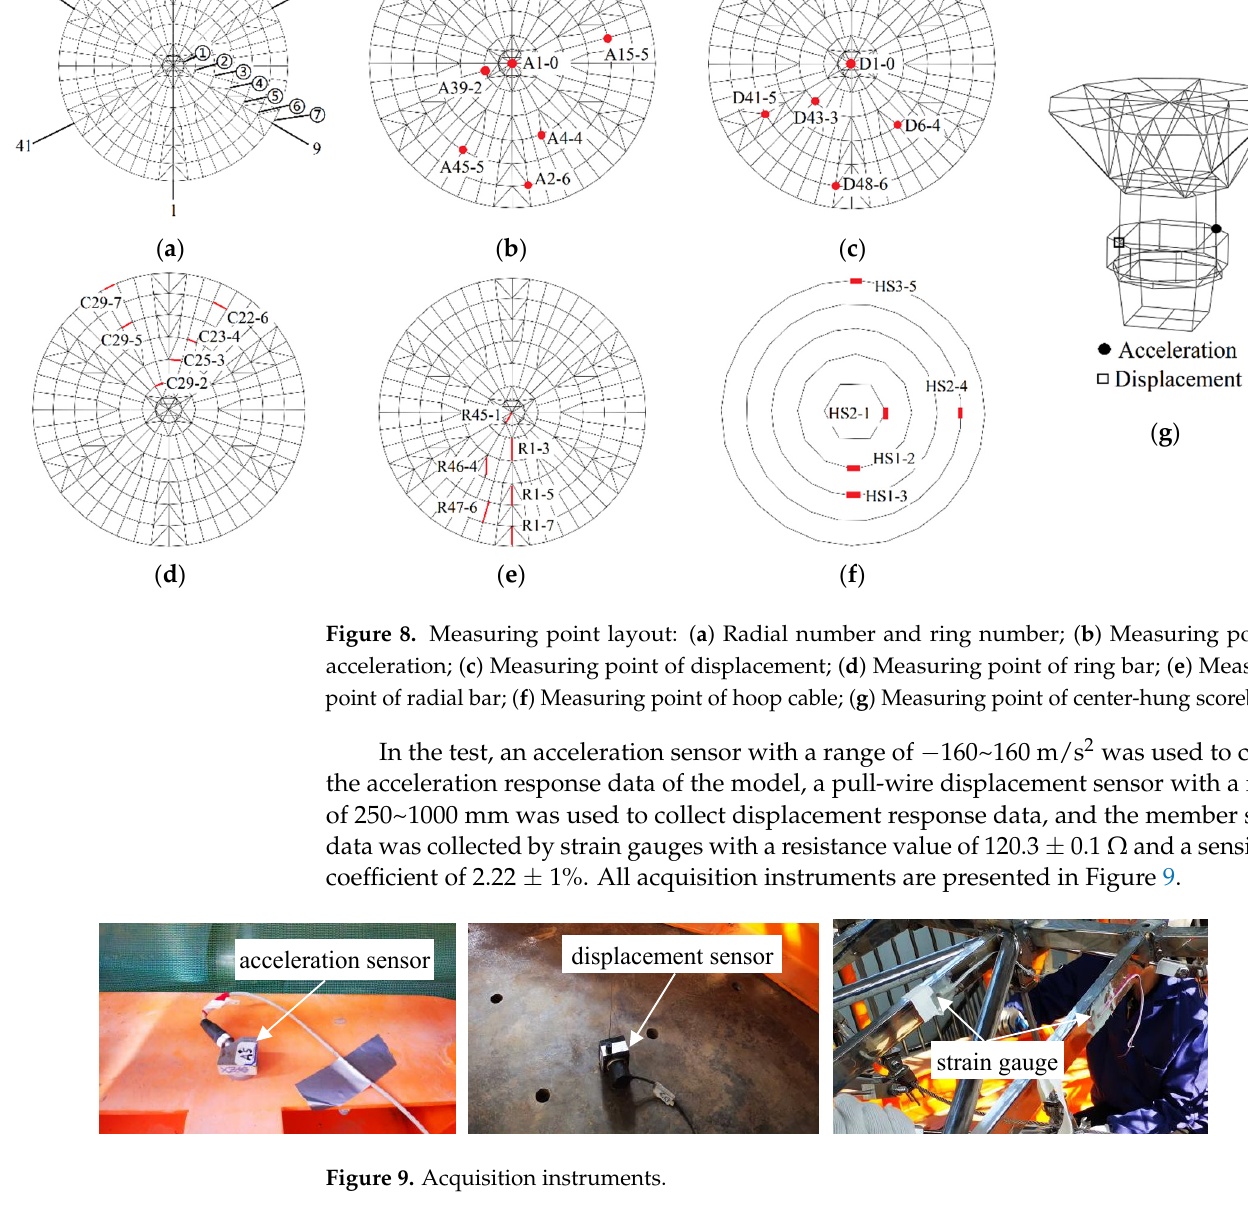
Figure 9. Acquisition instruments.